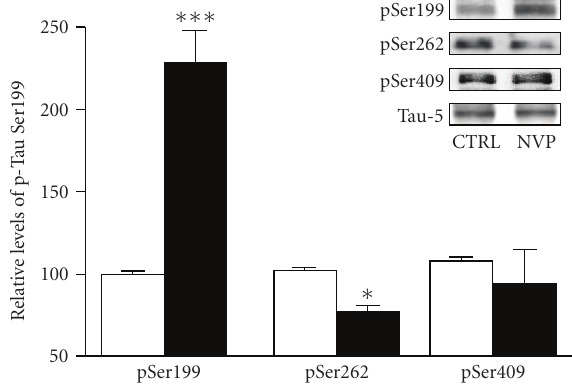
Figure 2: Blockade of NR2A-containing NMDA receptors is not associated with increased Tau phosphorylation levels at Ser409 and Ser262 sites. Phosphorylation and protein levels were estimated by Western blotting on cell extracts (40 μ g proteins) obtained from acute hippocampal slices treated with 50 nM NVP for 2 hours. Phosphorylated Tau levels, expressed relative to total Tau (i.e., Tau-5) levels, were measured using antibodies raised against Tau phosphorylated at Ser199, Ser262, and Ser409. The data were expressed as percentage of control values and are means ± SEM of 3 measurements per cell extract obtained from 6 di ff erent rats. Since these experiments were independently performed, we determined statistical significance using unpaired T -Test. ∗ P < . 05, ∗∗∗ P < . 0001, NVP-treated versus